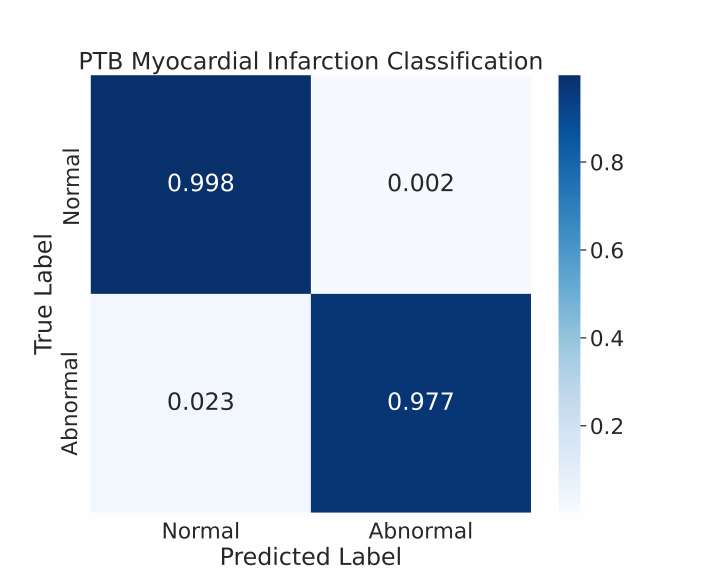
Figure 14. The confusion matrix for the PhysioNet PTB Myocardial Infarction classification.